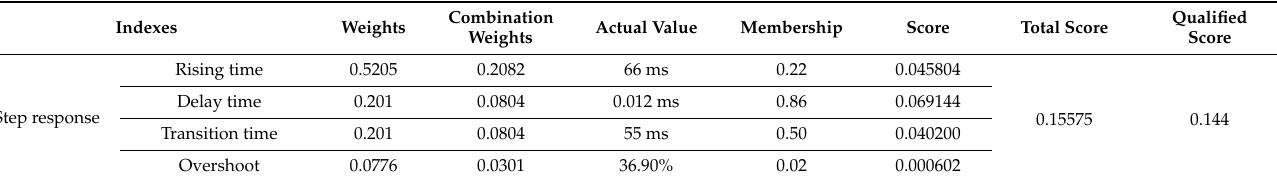
Table A1. PID controller speed evaluation table.